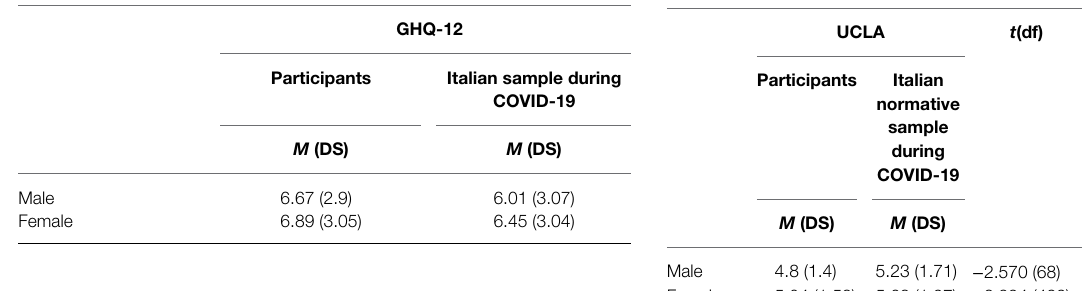
TABLE 4 | Mental health comparison between the average values of the participants and the average values of the first wave (Coppola et al., 2021).